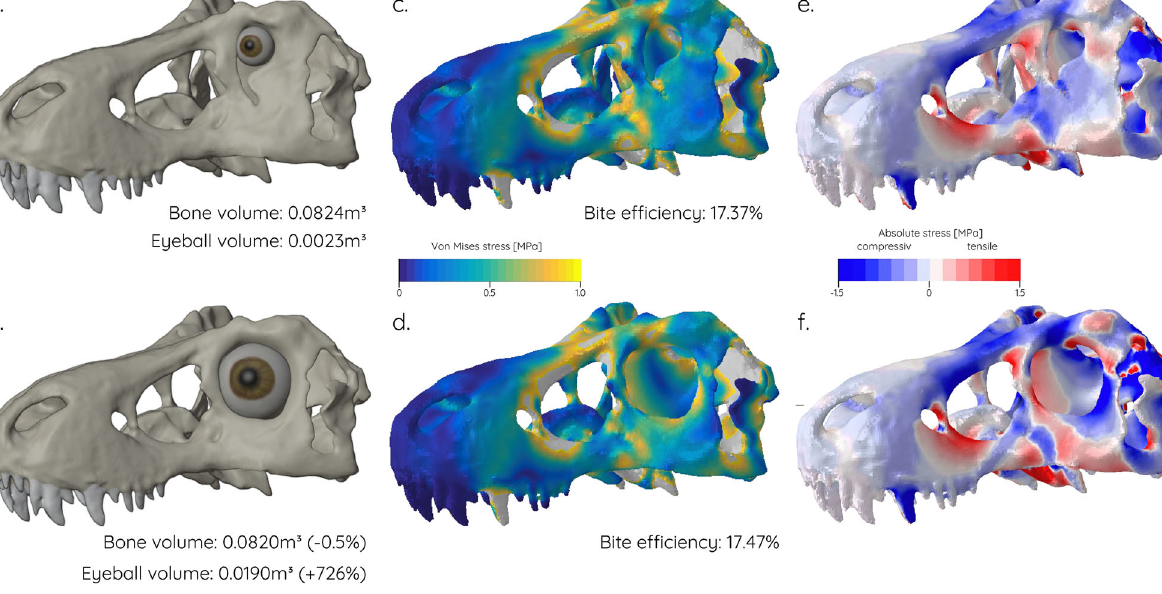
Fig. 8 Comparison of actual and hypothetical Tyrannosaurus models. a , c , e Original orbit shape, b , d , f circular orbit shape. a , b Osteological models with reconstructed eyeball fi tted to the size of the orbit; c , d von Mises stress contour plots; e , f compressive and tensile stress contour